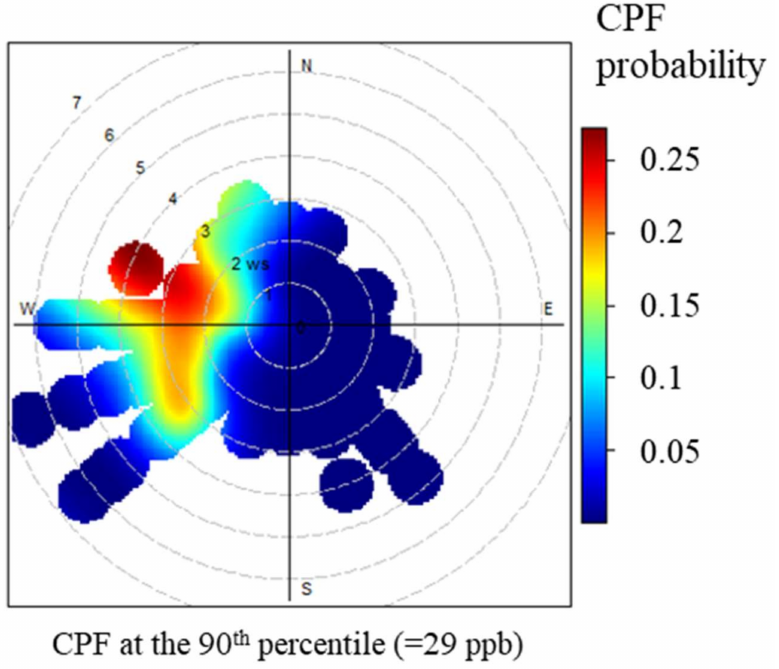
Figure 6. Conditional probability function (CPF) result at the 90th percentile for the atmospheric NH 3 during June 2020 in Jeonju